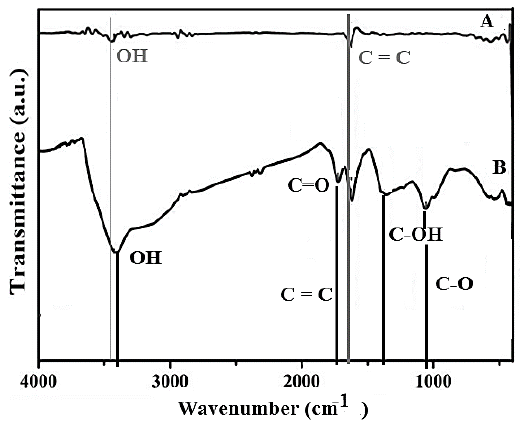
Figure 4. Fourier transform infrared spectroscopy (FT-IR) spectra of A-natural graphite and B-GO.